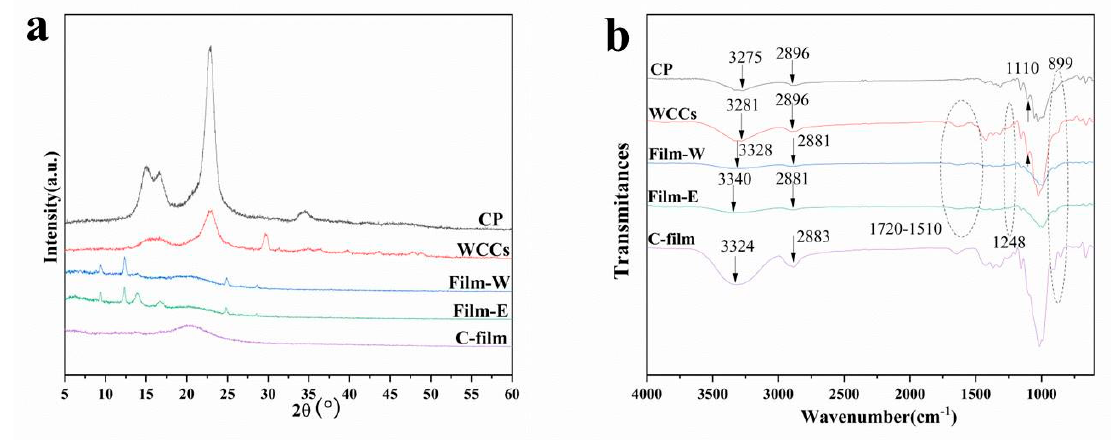
Figure 4. ( a ) XRD and ( b ) FTIR profiles of CP, WCCs, C-film, Film-W and Film-E. The FTIR spectra of CP, WCCs, and films regenerated in ethanol (Film-E) and deionized water (Film-W) are illustrated in Figure 4b. The WCCs and CP show similar FTIR spectra, but there are minor differences. The WCCs show obvious broad peaks ranging from 1720 cm − 1 to 1510 cm − 1 , which is ascribed to the overlapped peak of C=O stretching band of hemicellulose (1740 cm − 1 ) and aromatic ring stretching band of lignin (1510 cm − 1 ) [18,31,46]. Meanwhile, the WCCs also display another characteristic peak of lignin at 1248 cm − 1 [18,31,46]. Additionally, Film-W and Film-E also exhibit the above characteristic peaks, suggesting that lignin and hemicellulose are still confined in cellulose-based films after WCCs dissolution and regeneration, which corresponds with UV–Vis results. However, the peek at 1110 cm − 1 , which is obvious in spectra of raw materials CP and WCCs, disappears in C-film, Film-W and Film-E. Moreover, the peek at 899 cm − 1 is weak in the spectra of raw materials, strengthened in that of C-film, Film-W and Film-E. Meanwhile, CP and WCCs exhibit obvious peek at 3275 cm − 1 and 3281 cm − 1 , respectively, attributed to the O-H stretching band, which shows a blue shift for C-film (3324 cm − 1 ), Film-W (3328 cm − 1 ), and Film-E (3340 cm − 1 ). Similarly, the peak is located at 2896 cm − 1 for both CP and WCCs ascribed to the C-H stretching band, but it displays a redshift and reaches 2883 cm − 1 for C-film, and 2881 cm − 1 for Film-W and Film-E [18]. These results indicate the changes of hydrogen bonds and cellulose crystalline structure, which is consistent with the results of the XRD results. It is worth noting that there are some differences between C-film and cellulose-based films (Film-W and Film-E), indicating that lignin and hemicellulose in Film-W and Film-E may have an impact on the recrystallization of cellulose. In addition to these differences, the WCCs, Film-W and Film-E show similar curves, suggesting that cellulose is the main component, and AmimCl is the nonderivative solvent for WCCs.